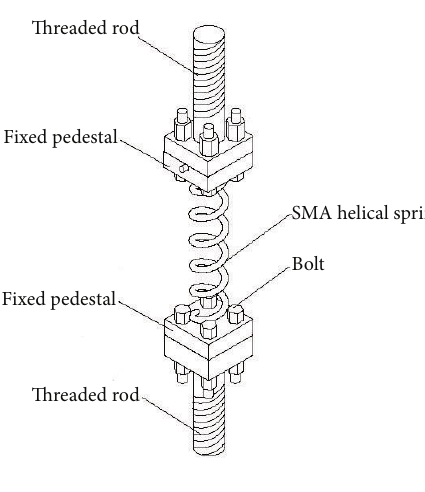
Figure 2: Configuration of the clamping